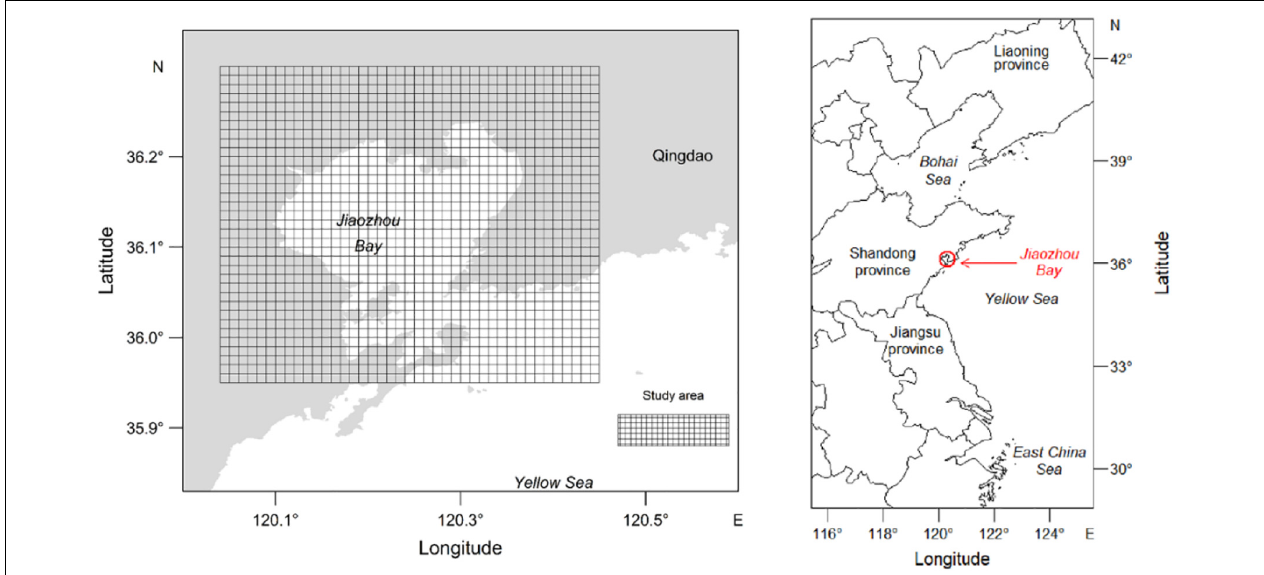
FIGURE 1 | Fenneropenaeus chinensis hatchery program implements in the Jiaozhou Bay, China. Study area is shown on the left . Chinese water area ranging from East China Sea to Bohai Sea is shown on the right .